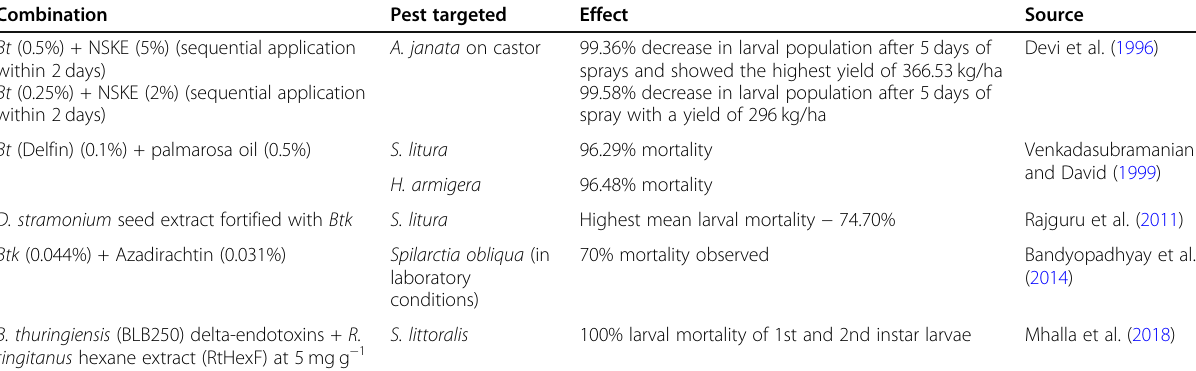
Table 1 Few botanicals and entomopathogenic bacteria combinations Combination Pest